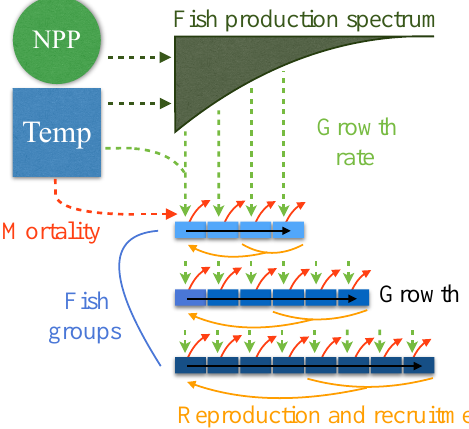
Figure 1. Schematic diagram of the main modules, components, and processes of the ecological module of BOATS. Net primary pro- duction (NPP) and temperature ( T ) force the model and are used to calculate the fish production spectrum, by assuming a transfer of en- ergy from phytoplankton to successive sizes of fish that depends on the trophic efficiency and the predator to prey mass ratio. From fish production, we calculate the size-dependent growth rate of biomass in three independent groups that represent small, medium, and large commercial fish. Mortality rates are calculated as a function of size and asymptotic size, and also depend on temperature. Adult fish, the largest sizes in each spectrum, allocate energy to reproduction, of which a fraction is returned to the smallest mass class of the cor- responding spectrum, representing recruitment of